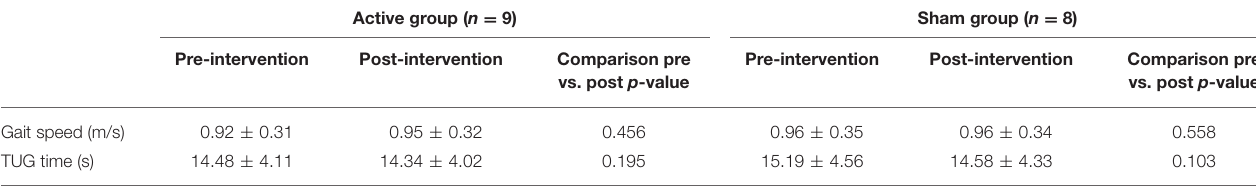
Values are reported as mean ±